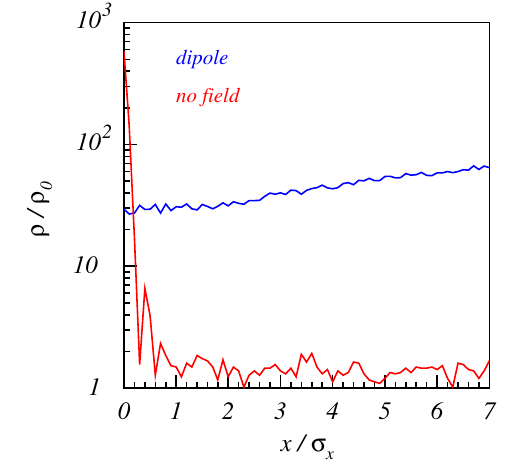
FIG. 5. (Color) Density enhancement in the outermost stripe as a function of horizontal stripe position, for a field-free region and a